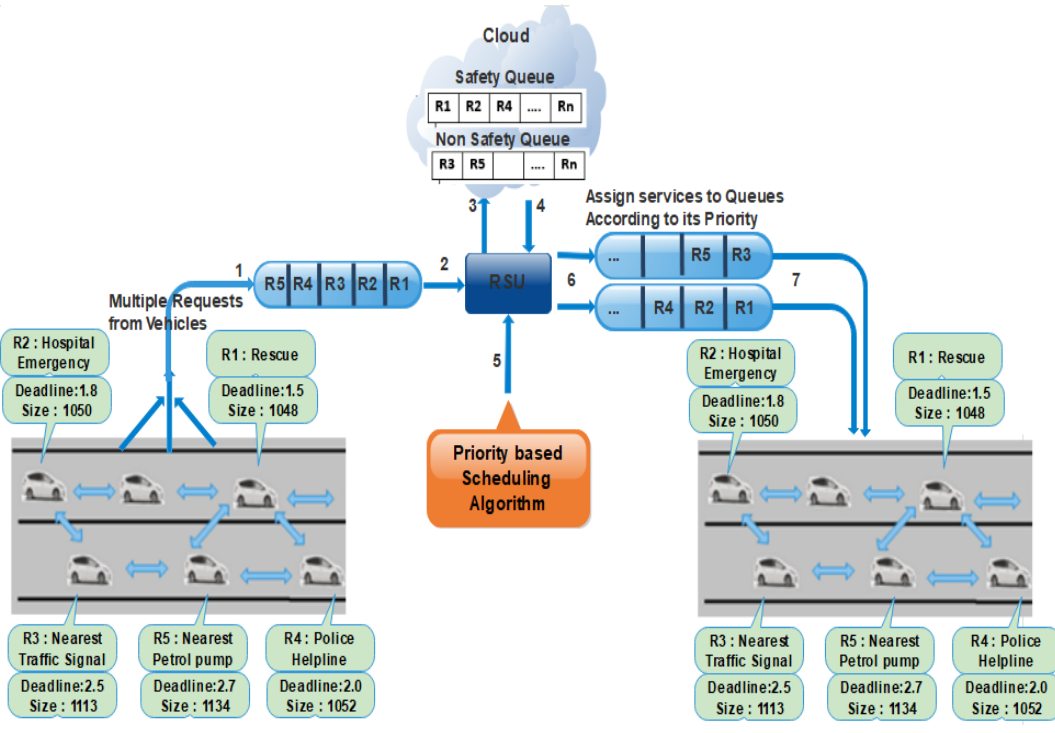
Figure 3. A walk through Example of